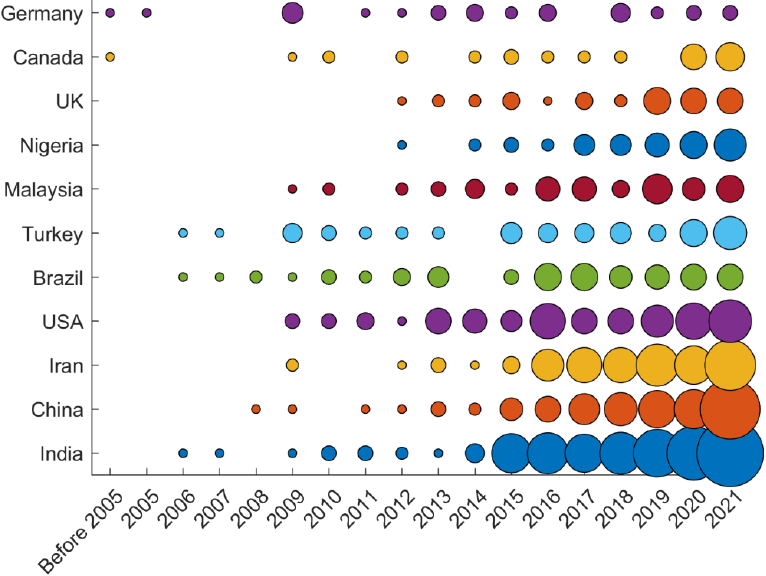
Figure 2. Graphical representation of the most productive countries in AI in bioenergy research from 1991 – 2021.